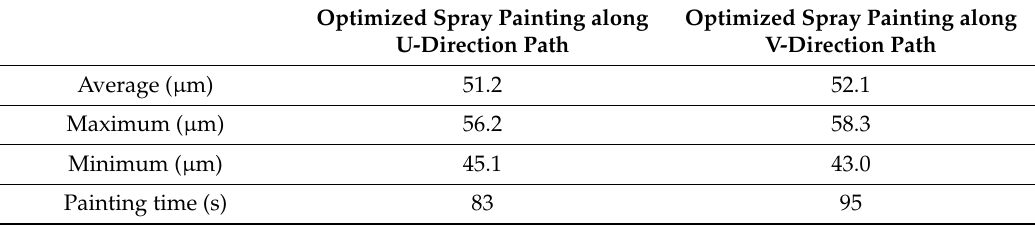
Figure 15. The Paint thickness Curve Spray painting along the V-direction Path. Table 2. The Experimental Results of Spraying. Optimized Spray Painting along U- Direction Path